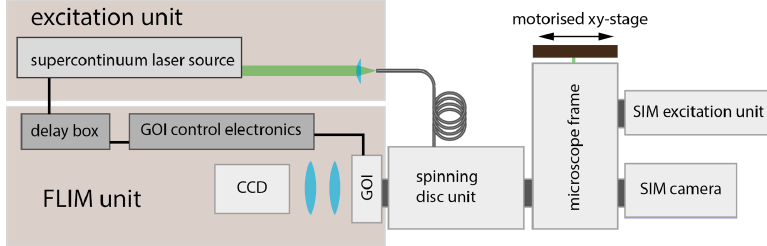
Figure 1. Experimental configuration for SIM and FLIM applied to the same field of view.